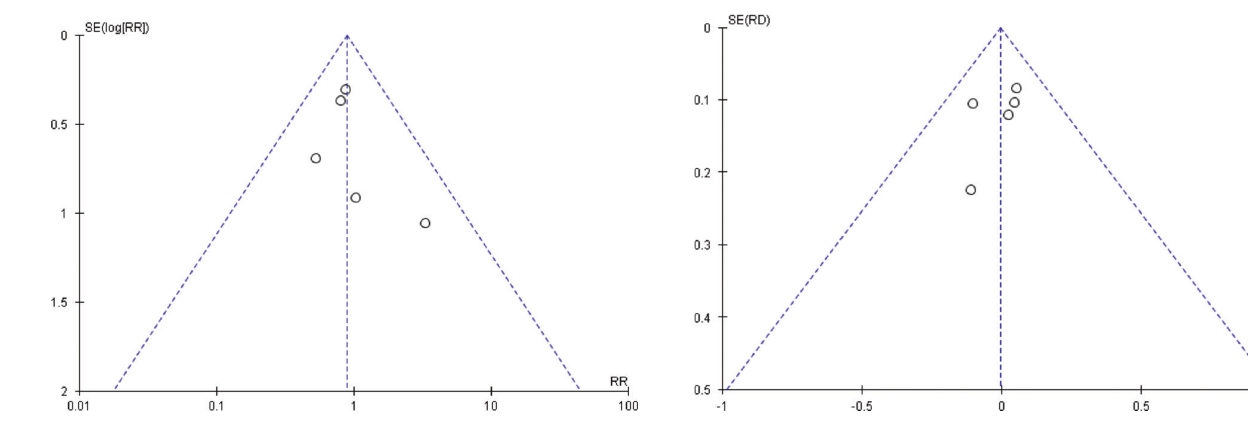
Figure 5 - Funnel plot of major complications in retrospective studies. All studies are inside the funnel plot.